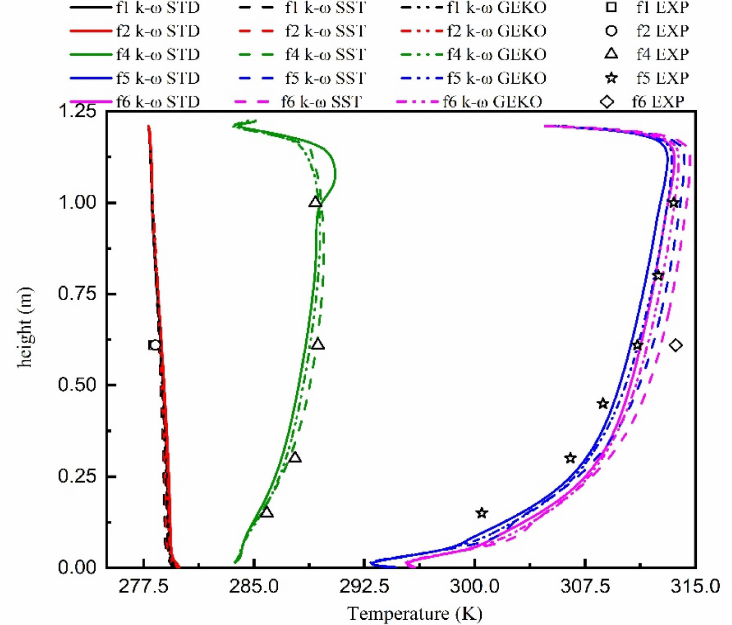
Figure 13. Experimental and numerical temperatures for the three glazings, according to k-w models.